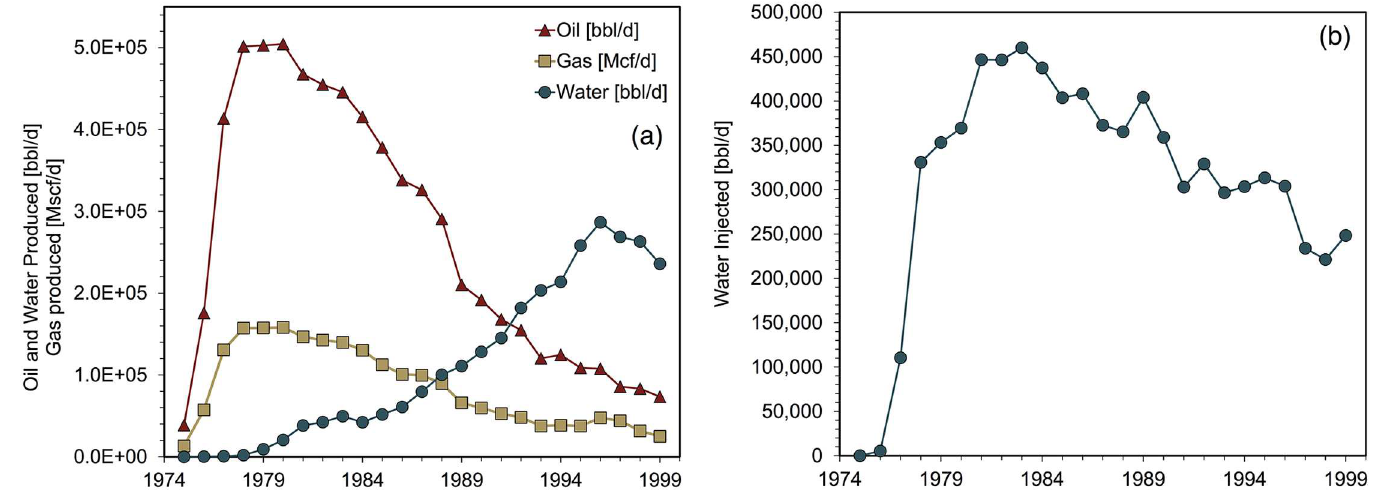
Fig 3. Forties input data for fluid production and injection. (a) Fluid production, (b) fluid injectionSources: [27, 36,